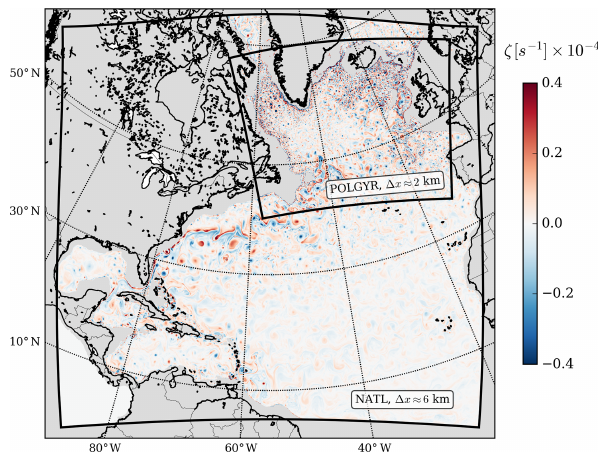
Figure 1. Snapshot of the relative vorticity at 500m of depth in the North Atlantic in the NATL simulation. The NATL grid ( (cid:49)x ≈ 6km) covers most the North Atlantic, and the POLGYR grid (smaller rectangle, (cid:49)x ≈ 2km) covers the subpolar gyre.